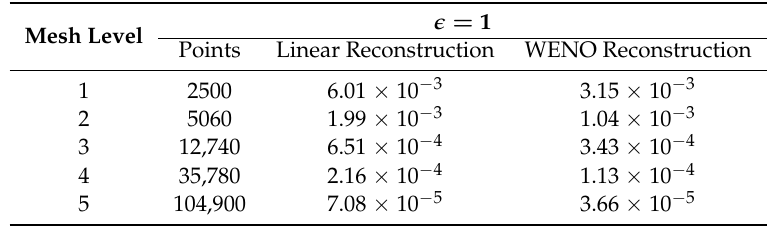
Table 2. Approximation investigation of f 2 . The error of variance (var. err.) for linear reconstruction and WENO reconstruction.